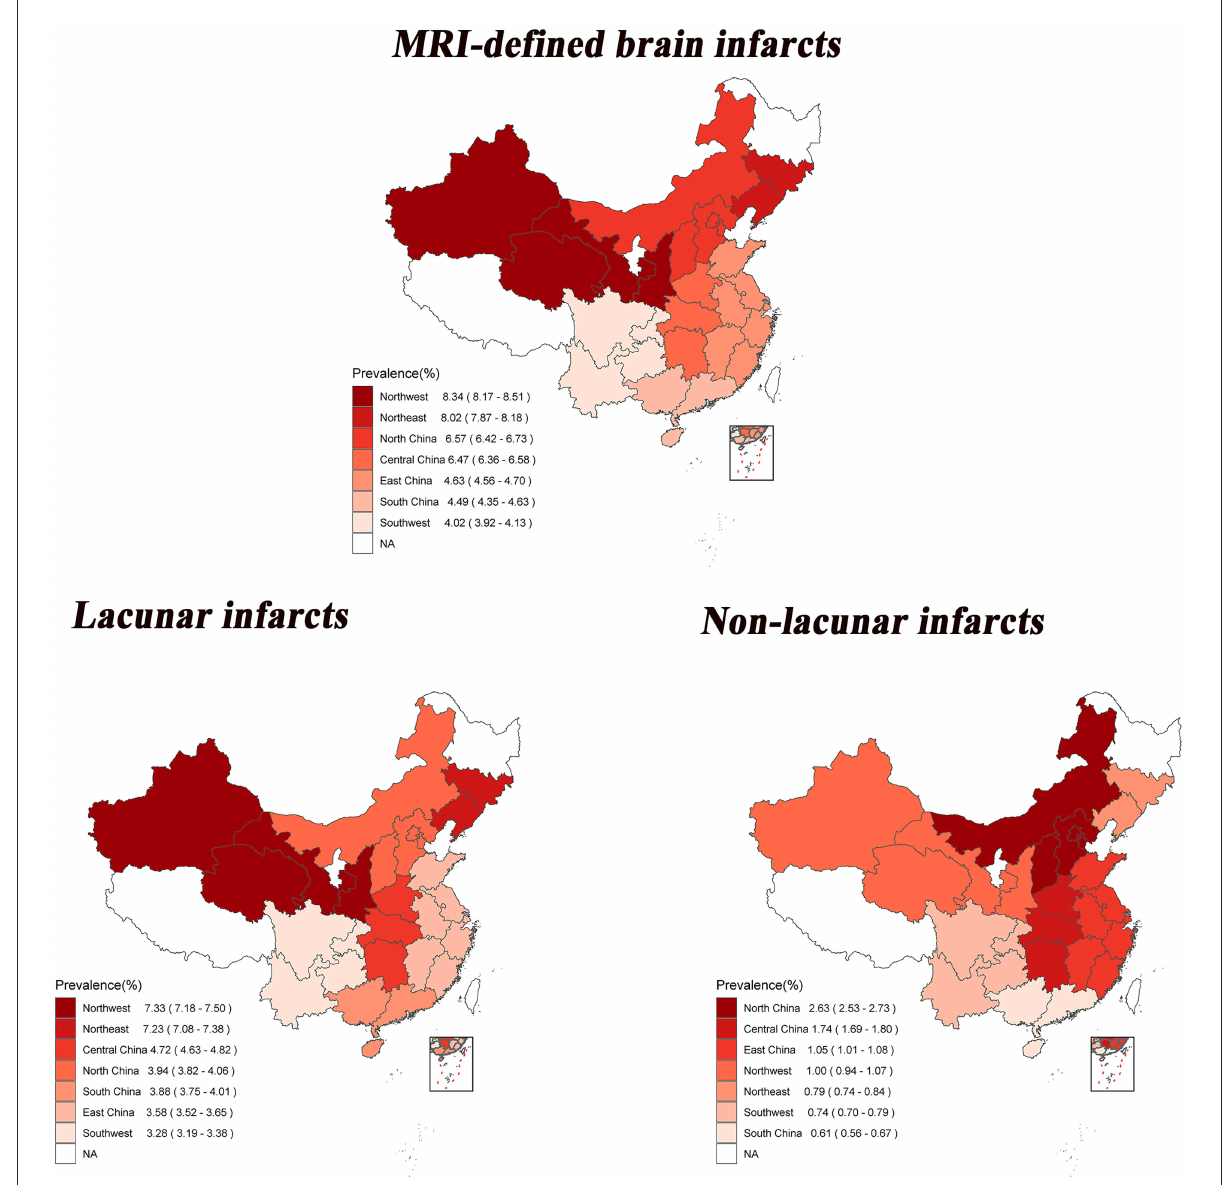
FIGURE1 Age-and sex-standardized prevalence of brain infarcts among 28 provinces in China by geographical regions. The statistical data mentioned here do not include Heilongjiang, Ningxia, Tibet, Hong Kong, Macao and Taiwan.